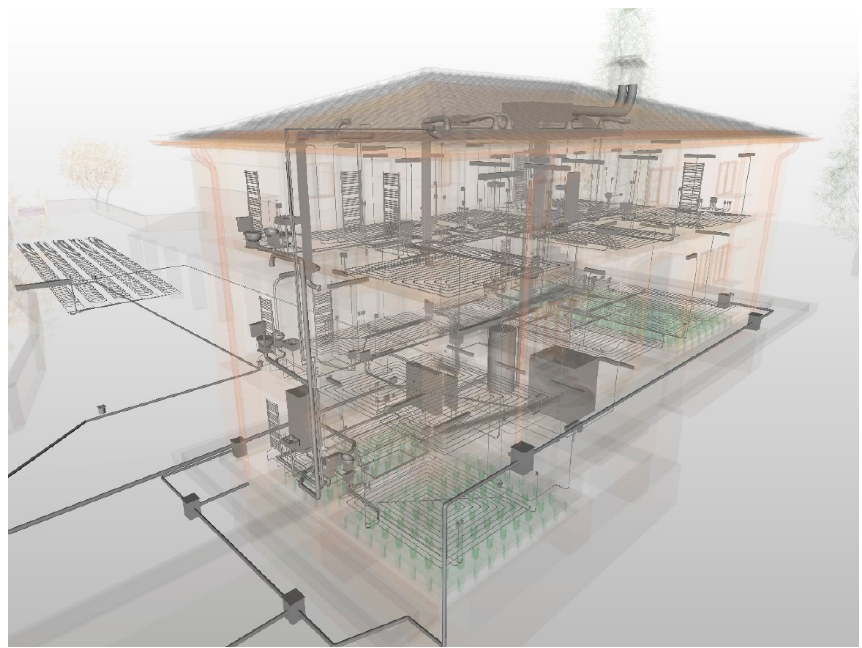
Figure 4. 3D view of the multidisciplinary (Mechanical–Electrical–Plumbing (MEP) model.